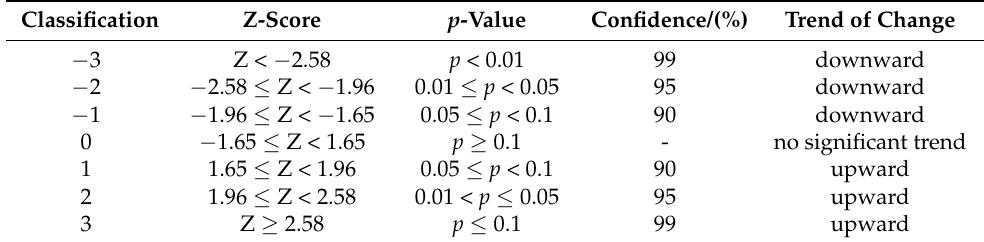
Table 5. Grading table of the variation trend of Archaeological Sites.